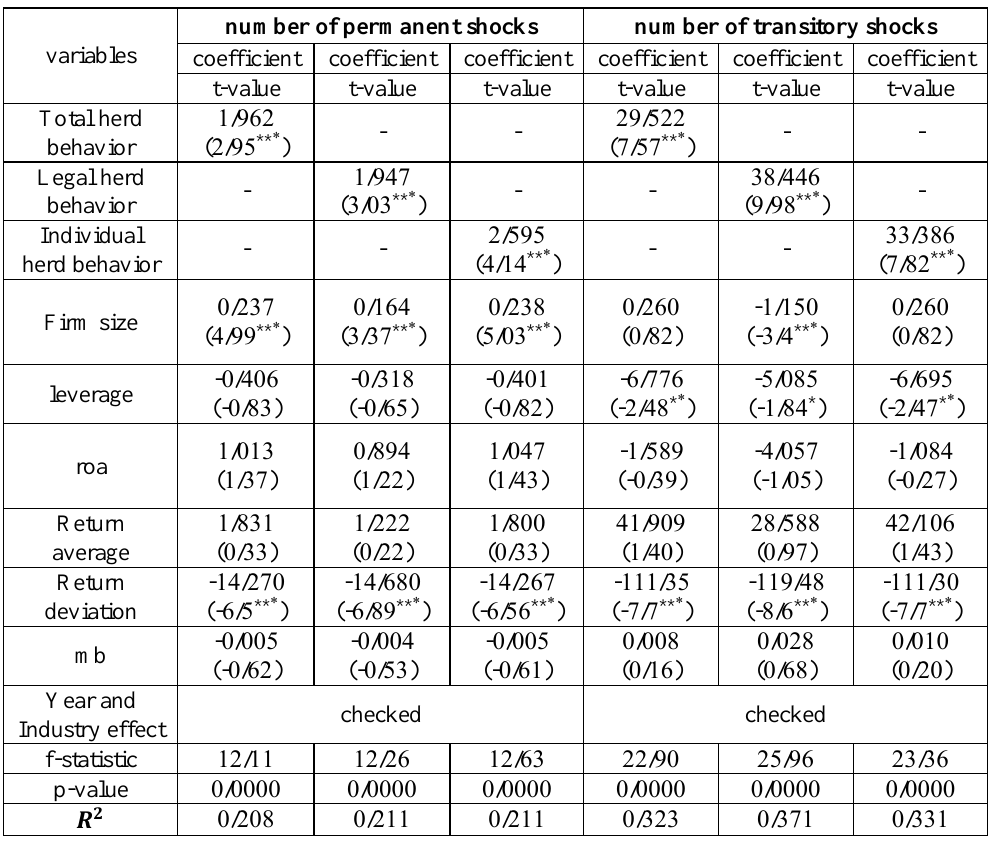
Table 3. relationship between herd behavior(total, legal, individual) and number of permanent and transitory